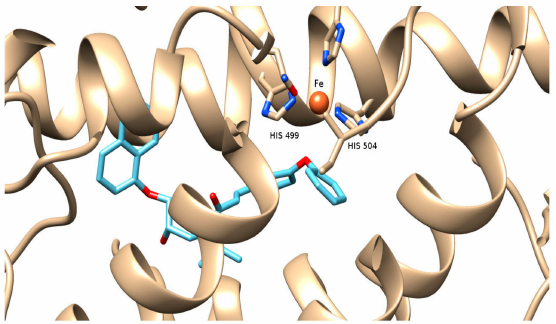
Figure 2. Docking pose of 2b (depicted in blue and red) bound to soybean lipoxygenase (LOX-1). The iron ion is depicted as an orange